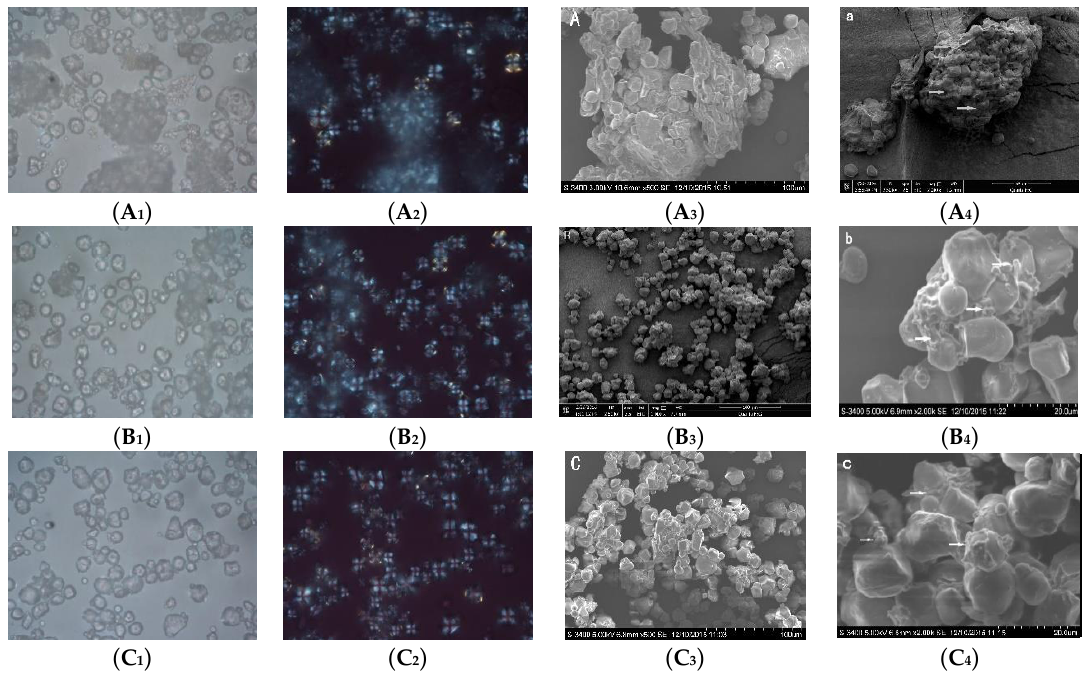
Figure 1. Morphological properties of corn flours. ( A ) dry-milling corn flour; ( B ) wet-milling corn flour; ( C ) enzymatic wet-milling corn flour. 1: Light microscopy of corn flour (10 × 50 times); 2: polarized light micrographs of corn flour (10 × 50 times); 3, 4: scanning electron microscopy of corn flour (with scale